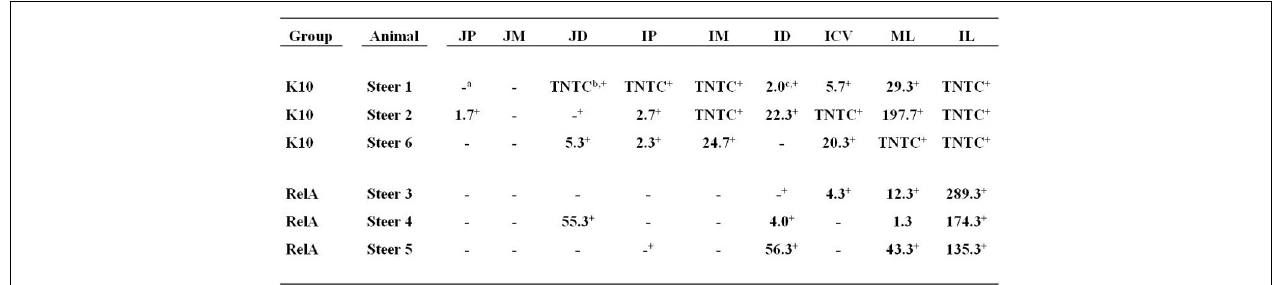
FIGURE 1 | Map culture results from nine tissue sites processed at necropsy. ThedataareexpressedastheaverageCFUoftriplicateagarcultures containing no hygromycin. No colonies were detected in the agar cultures containing hygromycin, which indicates (cid:2) relA was cleared in the vaccinated